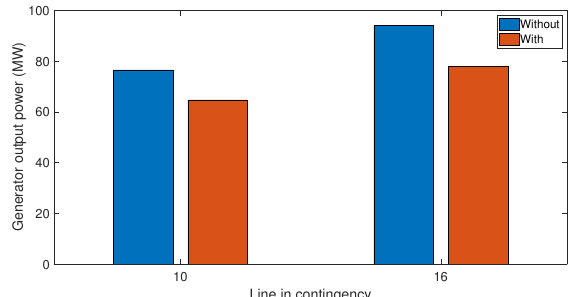
Figure 18. Power dispatch of renewable generator number 4 without and with loadability restrictions for contingencies in branches 10 and